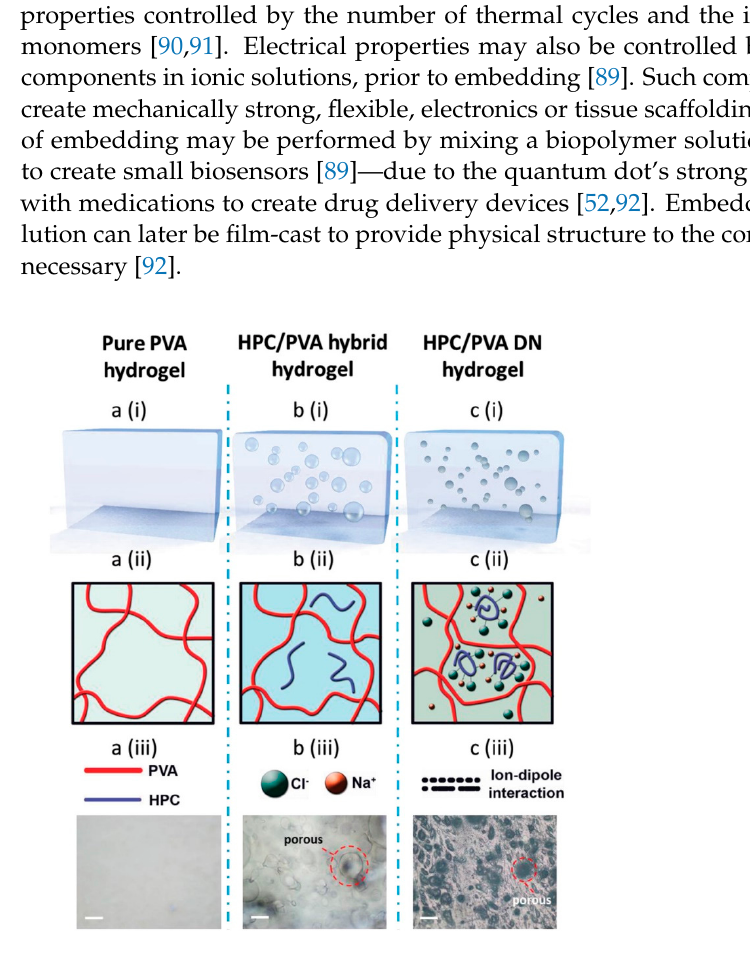
Figure 6. A diagram of three biopolymer-based hydrogels using embedding techniques [88]. ( a ) A pure hydrogel material of polyvinyl alcohol (PVA). ( b ) A hydroxypropyl cellulose (HPC) fiber embedded hydrogel (PVA + HPC). ( c ) A hydrogel embedded with ionically soaked fibrous materials (PVA + HPC + NaCl). Reproduced with permission from Wiley, 2018.